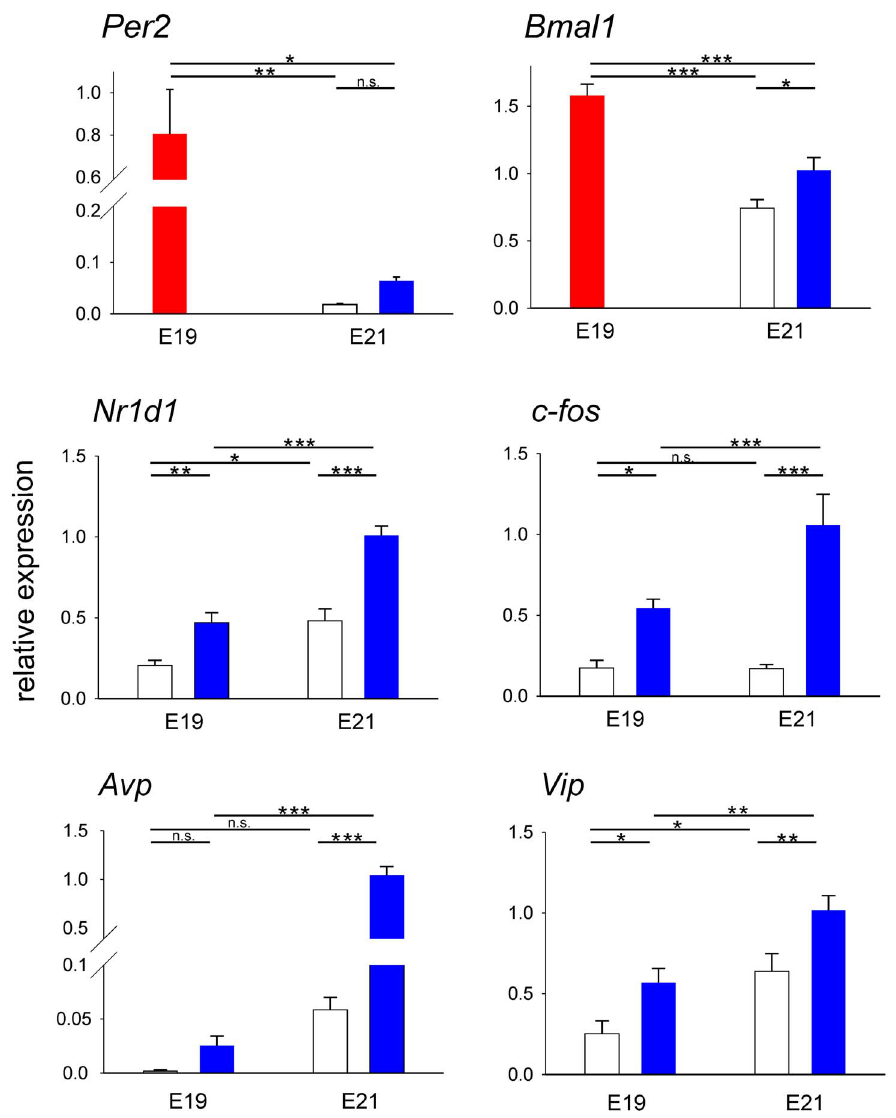
Figure 4. The comparison of gene expression levels in the rat SCN at E19 and E21. Relative expression of Per2 , Bmal1 , Nr1d1 , c-fos , Avp and Vip was detected at both fetal stages. SCN samples collected at time points representative of minimal (open columns) and maximal (blue columns) transcript levels during the 24-h interval (see Fig. 2 and Fig. 3) were assayed in the same PCR assay. For the non-rhythmically expressed Per2 and Bmal1 at E19, the mean of maximal and minimal levels is shown (red column). The results of a one-way ANOVA comparison between the groups are shown. *P , 0.05, **P , 0.01, ***P , 0.001, n.s., non-significant. E21 (ZT18 vs. ZT3; P , 0.001). The maximal (P , 0.001) but not minimal expression increased between E19 and E21.